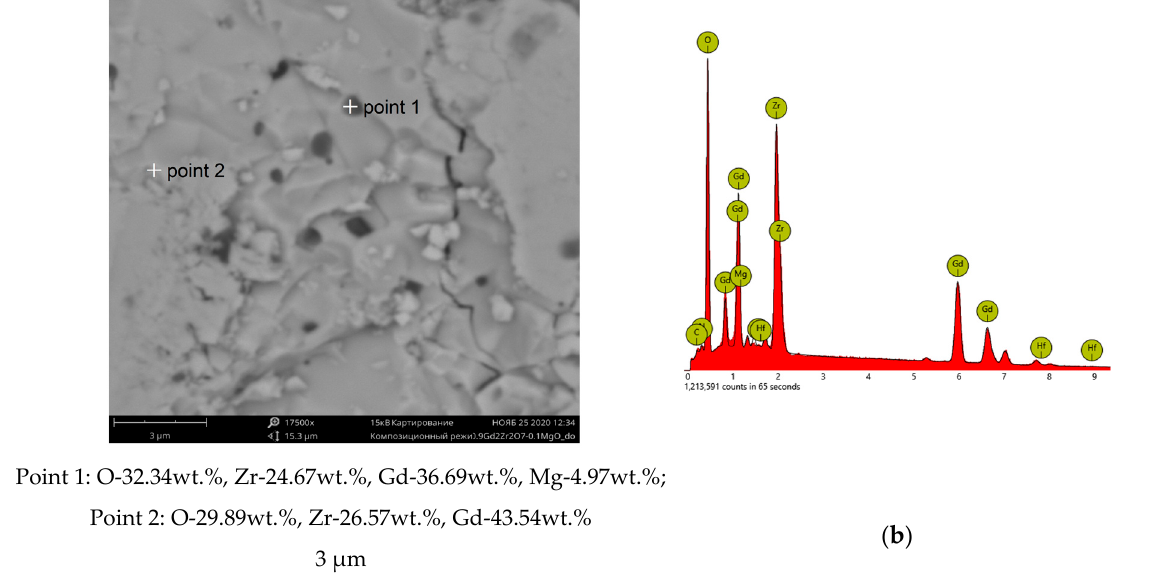
Figure 4. ( a ) SEM images of 0.90Gd 2 Zr 2 O 7 – 0.10MgO. ( b ) EDS spectra of 0.90Gd 2 Zr 2 O 7 – 0.10MgO in point 3. Table 3. The relative density of Gd 2 Zr 2 O 7 and (1- x )Gd 2 Zr 2 O 7 · x MgO samples.